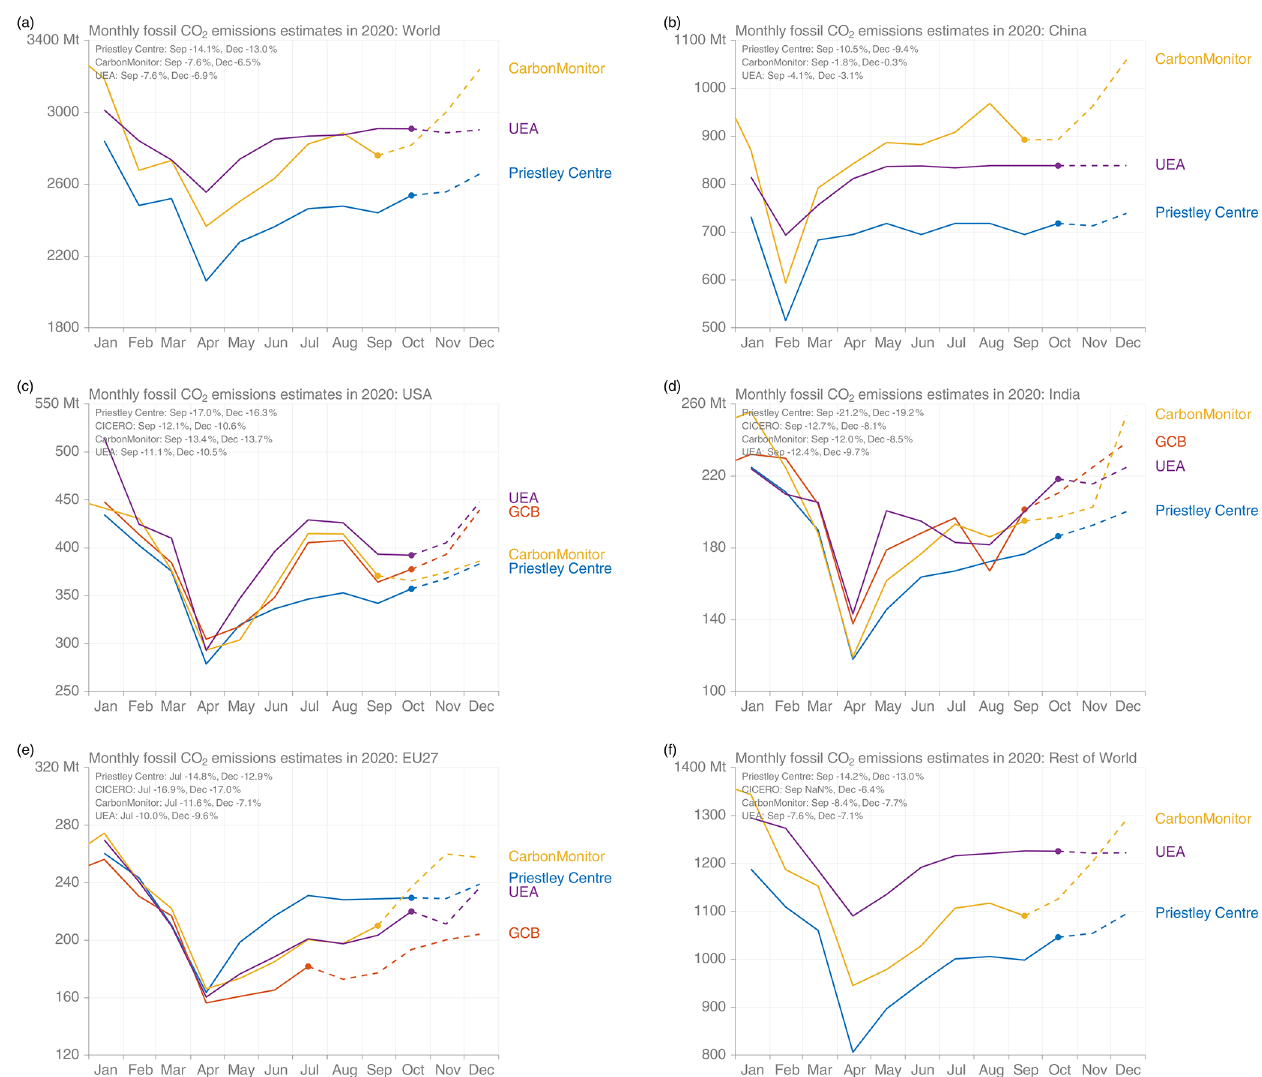
Figure B5. Monthly 2020 fossil CO 2 emission based on year-to-date data (solid lines) and projections (dashed lines) following four available approaches for (a) the whole world, (b) China, (c) the USA, (d) the European Union, (e) India, and (f) the rest of the world. Methods of the four approaches are described in Sect. 2.1.5 and Appendix